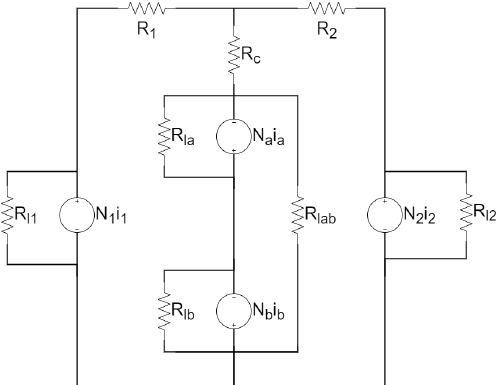
Figure 4. Reluctance model of the transformer used in Cuk converter with integrated